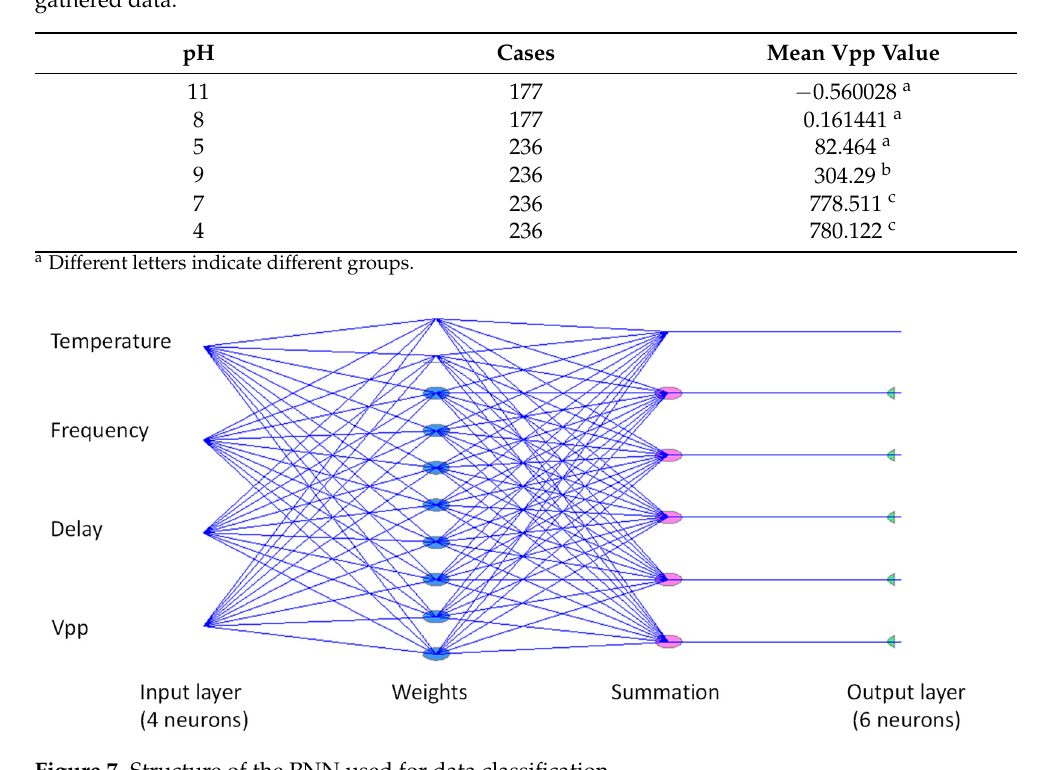
Figure 7. Structure of the PNN used for data classification.